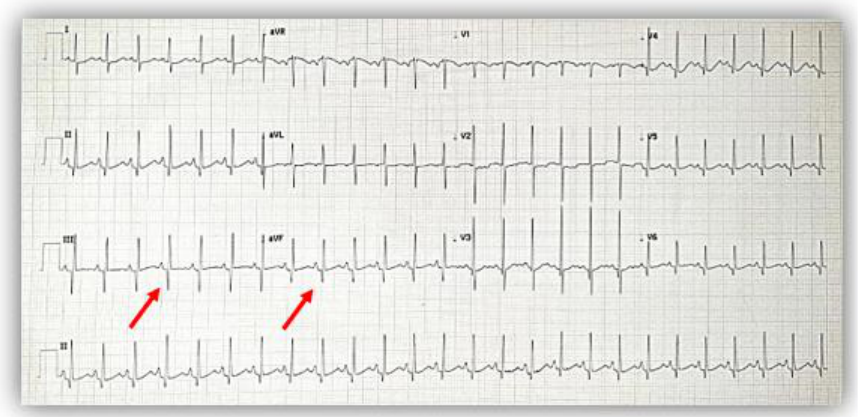
Figure 1. The electrocardiogram at admission showed a normal pattern except for deep Q waves (red arrows) in inferior leads (DIII, aVF).